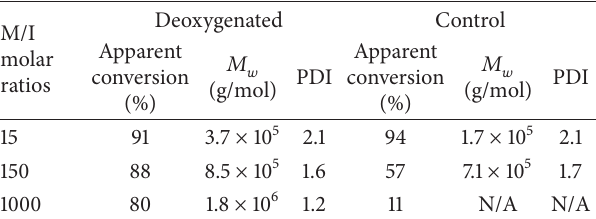
Table 1: Polymer weight loss of modified silica (in terms of apparent monomer conversion %) and weight-averaged molecular weight ( 𝑀 𝑤 , g/mol) and polydispersibility (PDI) of extracted polymer for deoxygenated and control admicellar polymerizations initiated by AIBN.